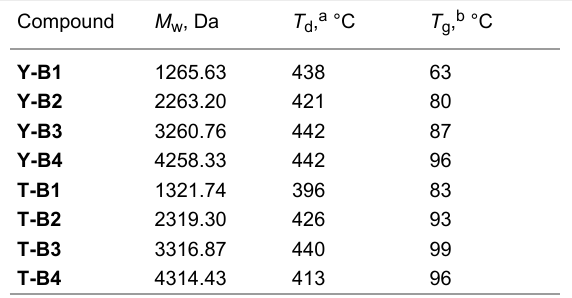
Table 1: Thermal properties of oligofluorene–BODIPY compounds.